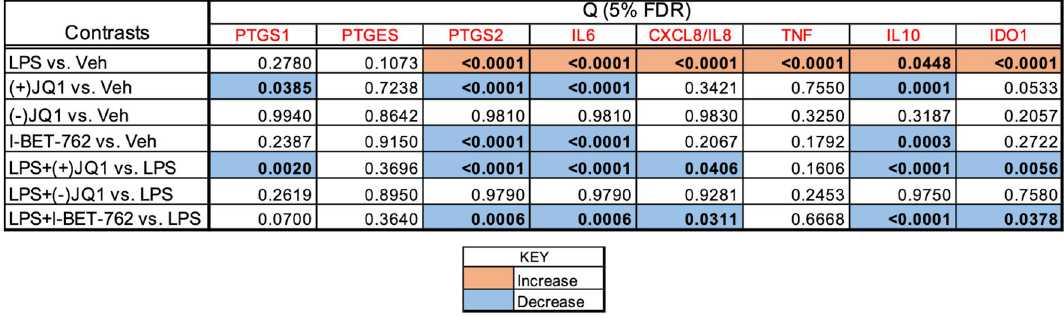
Fig 1. Heat map grid summarizing the effects of LPS and BET inhibitors on target gene mRNA expression in DSCs. Culture and treatment conditions, qRT-PCR assay details, and data processing are described in the Materials and methods section. The grid cells show significance values (Q) adjusted to the false discovery rate (FDR). The significance threshold is 5% FDR (Q < 0.05), highlighted in bold. The orange color indicates a significant increase, the blue color indicates a significant decrease regarding the contrasts shown. The gene symbols are in red. The Q values have been calculated by contrasting all treatments with each other (28 contrasts, listed in S4 Fig). The contrasts selected for display in the heatmap indicate LPS effects (LPS vs . Vehicle), drug effects ((+)-JQ1 or (-)-JQ1 or I-BET- 762 vs . Vehicle), and drug effects on the LPS response (LPS + (+)-JQ1 or (-)-JQ1 or I-BET-762 vs .